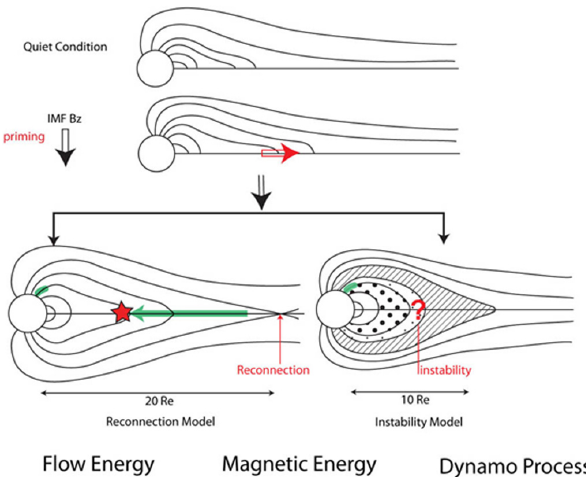
Fig. 17b. An example of substorm onset as shown by a sudden brightening of an arc. An arc located poleward of the initially brightening arc shows some activity after substorm onset (Akasofu et al., 2010).